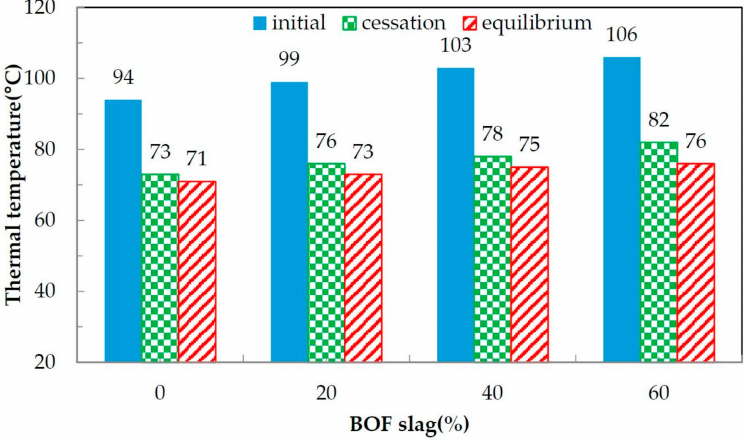
Figure 6. Relationship between the temperature intervals and the BOF slag contents (SMA).